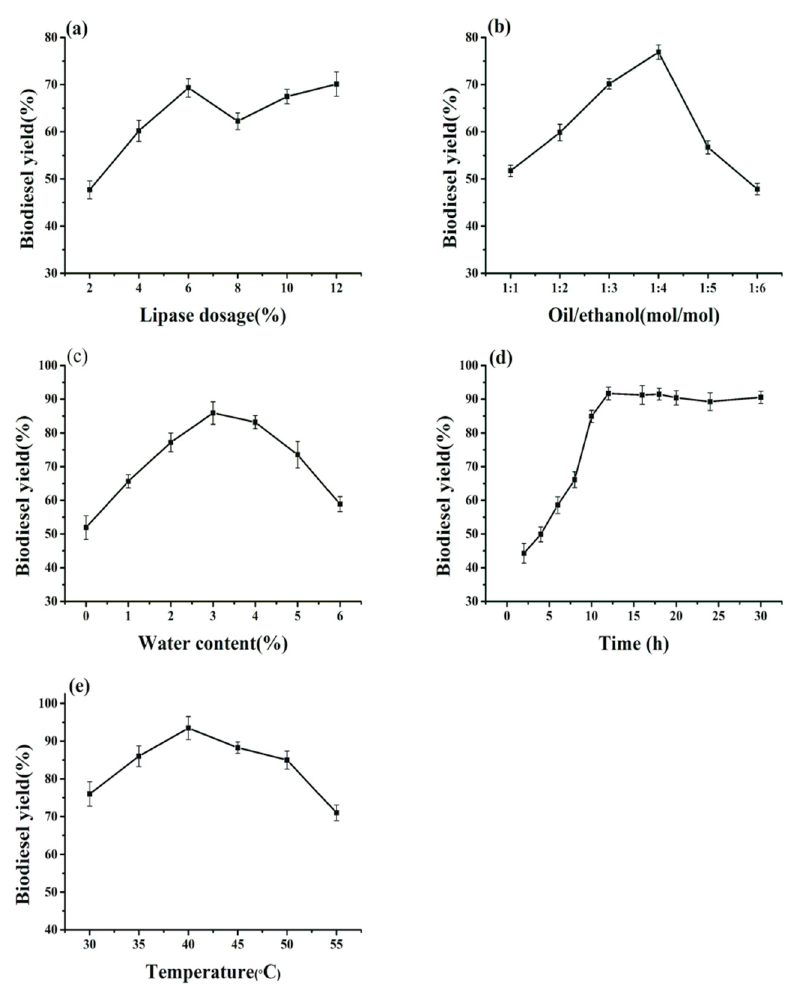
Figure 7. Influences of reaction parameters on biodiesel production catalyzed by BCL-ZIF-8: ( a ) lipase dosage; ( b ) molar ratio of oil to ethanol; ( c ) water content; ( d ) reaction time; ( e ) reaction temperature.